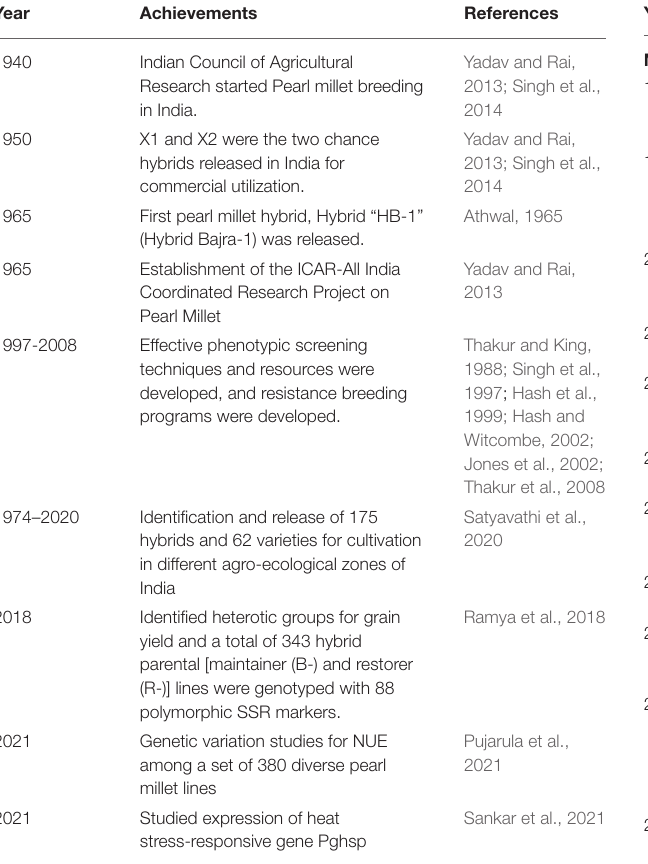
TABLE 1 | Achievements and milestones in pearl millet improvement through conventional/heterosis breeding.